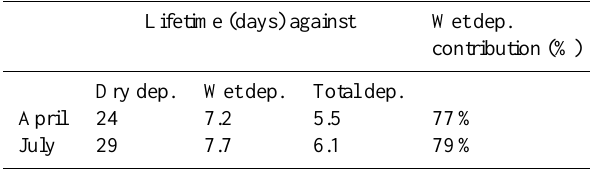
Table 1. Lifetime (days) of BC against dry, wet, and total deposi- tions and the contribution of wet deposition to the total deposition. Lifetime (days) against Wet